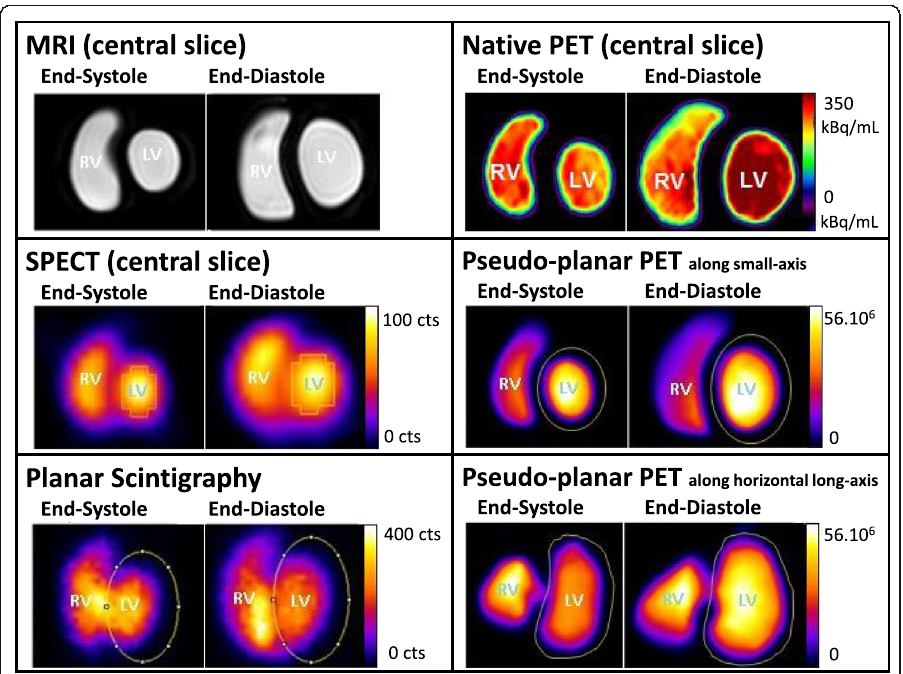
Fig. 4 Images of the end-diastole/end-systole heart-phantom pair. For the 3D modalities, namely, magnetic resonance imaging (MRI), single-photon emission computed tomography (SPECT), and native positron emission tomography (PET), only the central slice in the cardiac short axis is shown. The SPECT, planar scintigraphy, and “ pseudo-planar ” PET images show representative examples of manual segmentation. The “ pseudo-planar ” PET images along the cardiac small axis had better image quality (especially in terms of spatial resolution) than the equivalent planar scintigraphy images. LV, left ventricle; RV, right